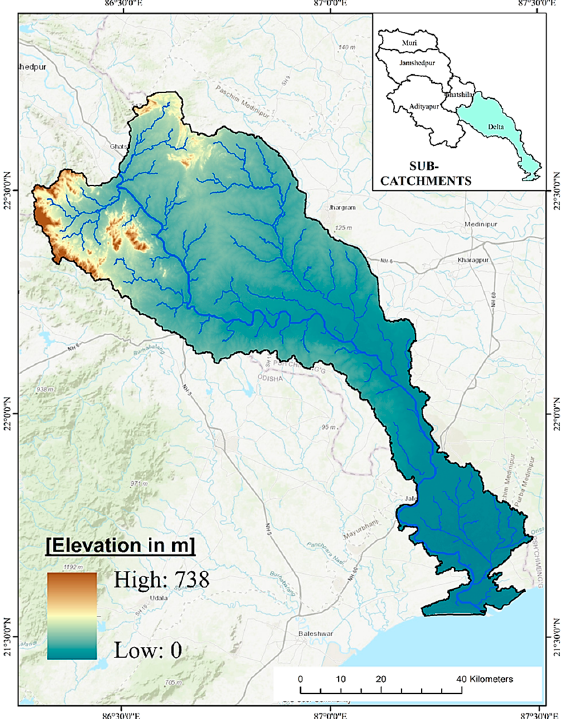
Figure A1. The elevation map of the Delta Sub-basin of the Subarnarekha River (Based on: srtm.csi.cgiar.org (accessed on 2 May 2022)).